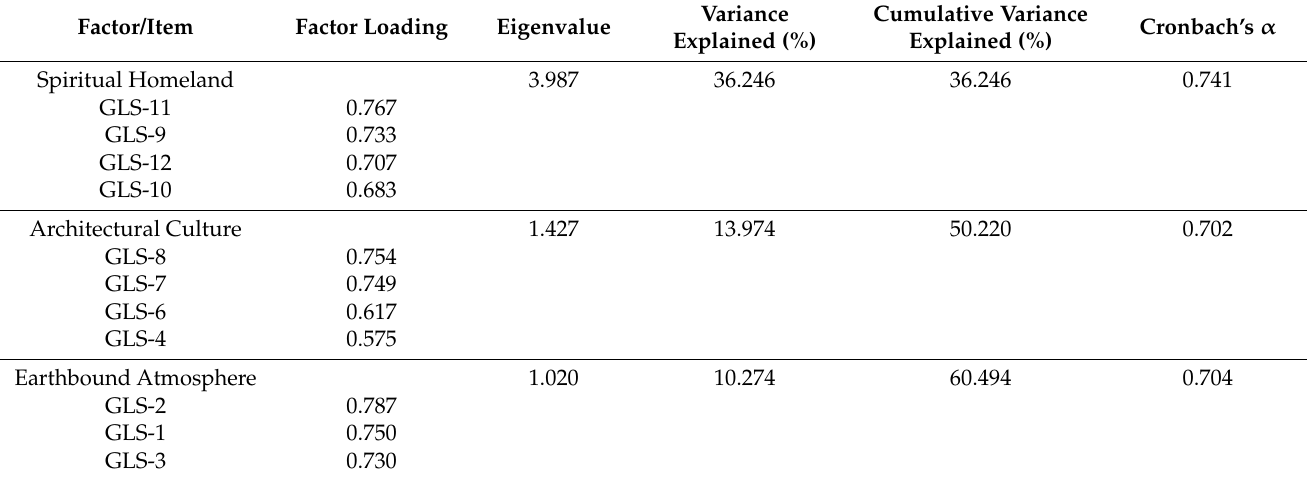
Table 4. Exploratory factor analysis results (sample 1, n =